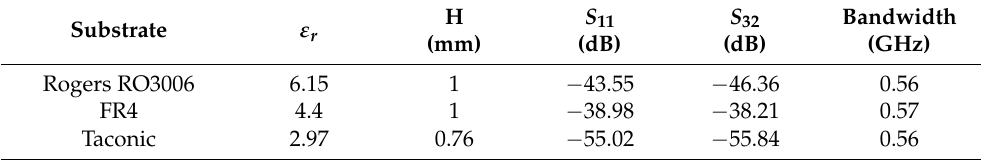
Table 1. Circuit simulation results of the proposed WPD designed at 3 GHz with different substrates. Substrate